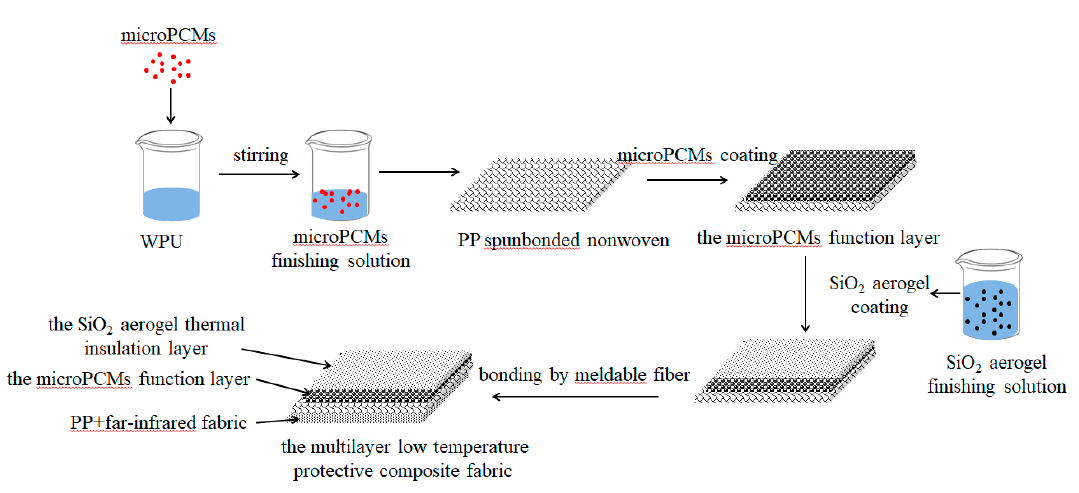
Figure 1. Preparation scheme for the multilayer low temperature protective composite fabric (MPF).